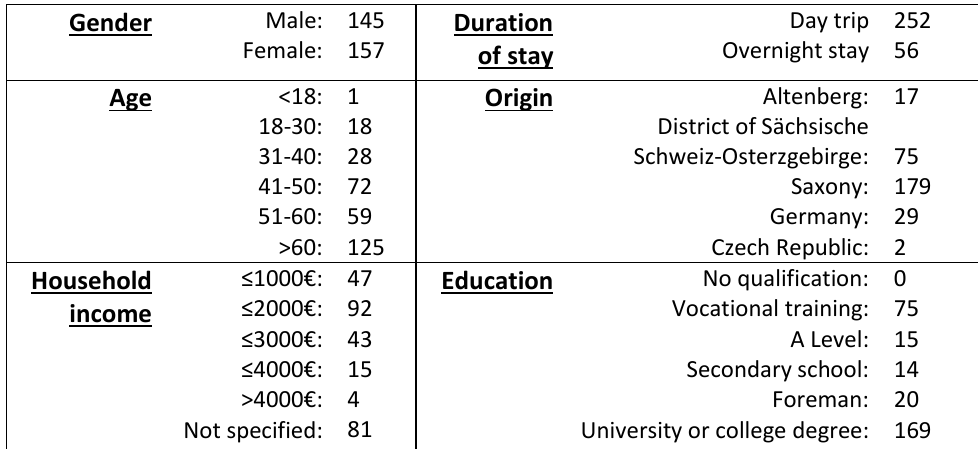
Table 2: Selected characteristics of surveyed visitors in the Eastern Ore